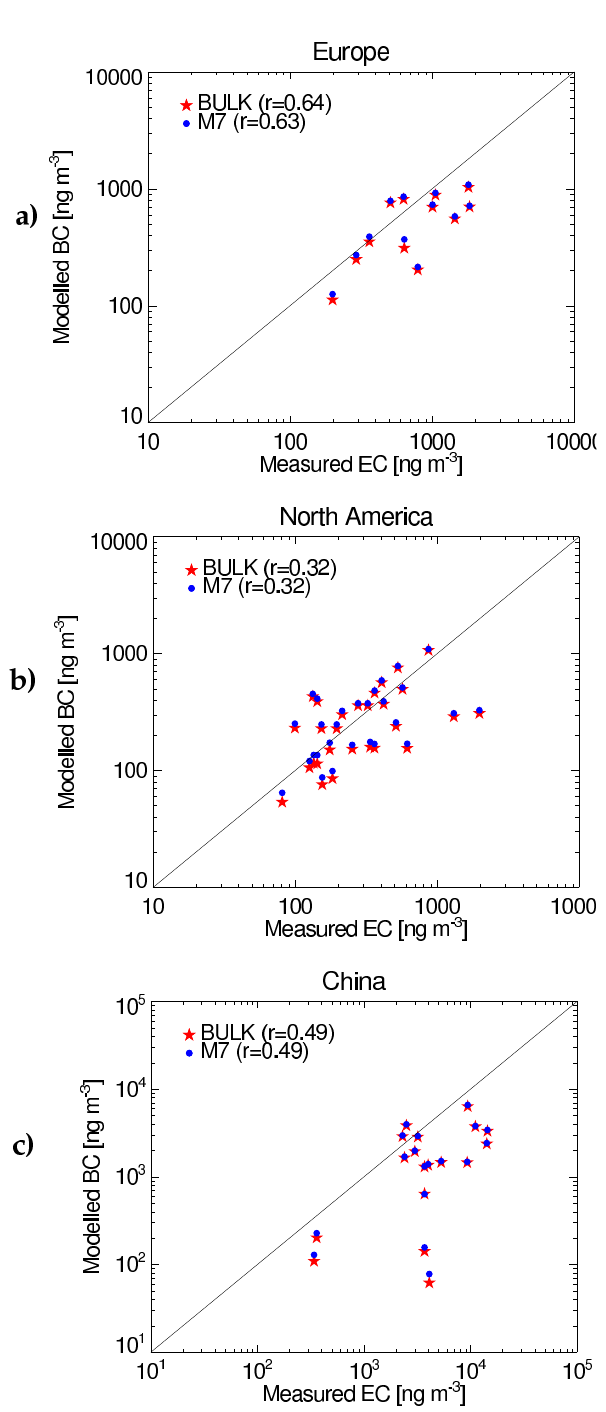
Fig. 3. Annual mean modelled (2005/2006) surface concentrations of BC [ngm − 3 ] with BULK and M7 versus measurements in Eu- rope (EMEP 2002/2003 campaign), North America (IMPROVE) and China (Zhang et al.